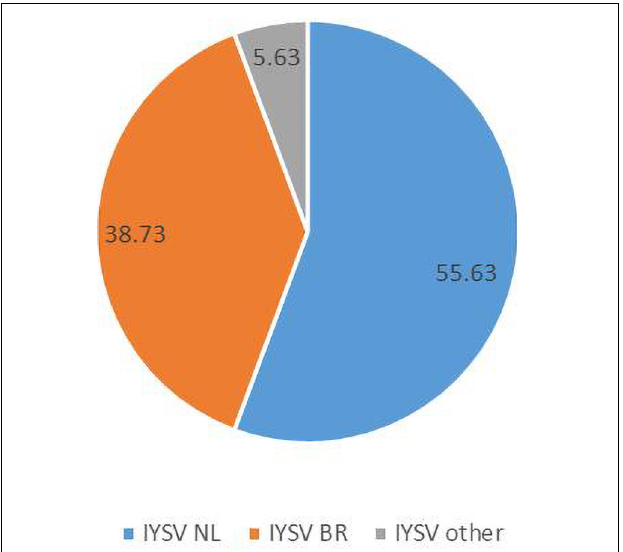
FIGURE 2 | Relative distribution of the global collection of Iris yellow spot orthotospovirus genotypes (indicated as percentages) based on Restriction Fragment Length Polymorphism.